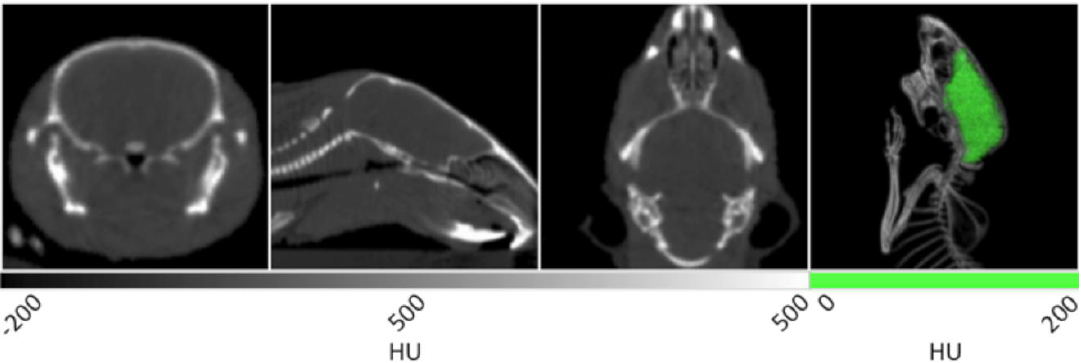
Figure 3. X-ray CT data of a murine brain and skull. Transverse, sagittal and coronal slices are displayed in the first three panels respectively. In the fourth panel is a 3D rendering of the same data with the brain tissue displayed in